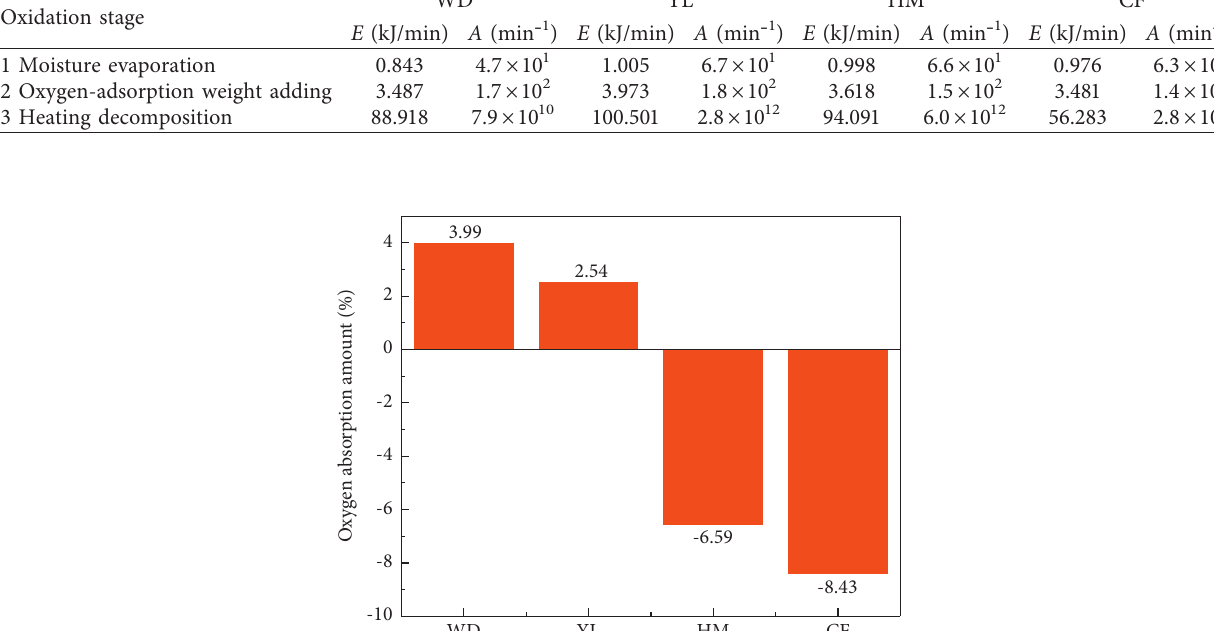
Table 4: Dynamics parameters of oxidation reaction of the coal samples, calculated at different temperature-rise rates and at different stages. Oxidation stage